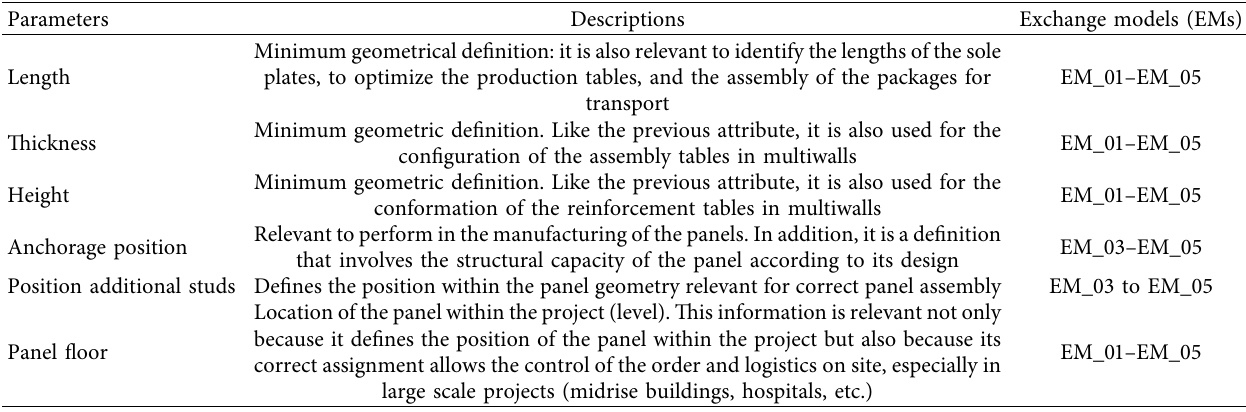
Table 4: Minimum geometric parameters associated with the development of prefabricated timber